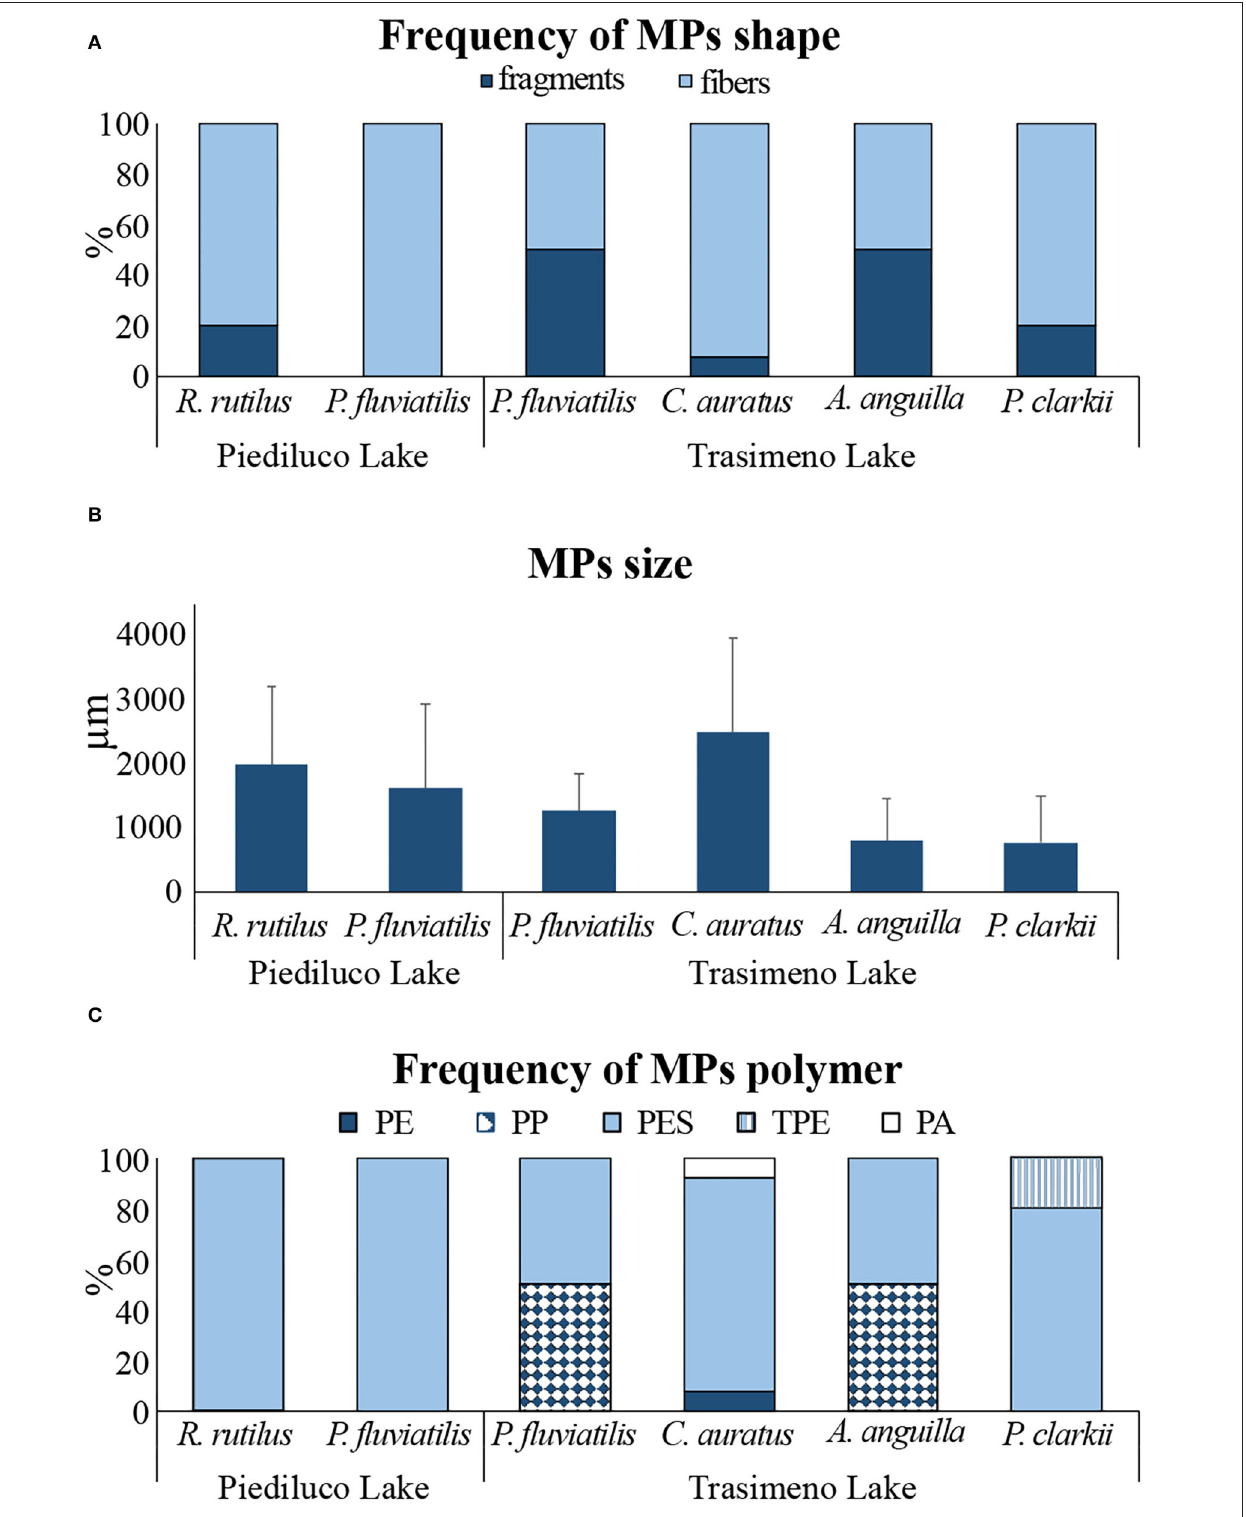
FIGURE 3 | Characterization of MPs extracted from the gastrointestinal tract of fish and from the whole soft body of crayfish sampled in Piediluco and Trasimeno lakes: (A) relative contribution of shapes (%), (B) size of ingested MPs per individual (mean ± sd), (C) relative contribution of polymers (%).